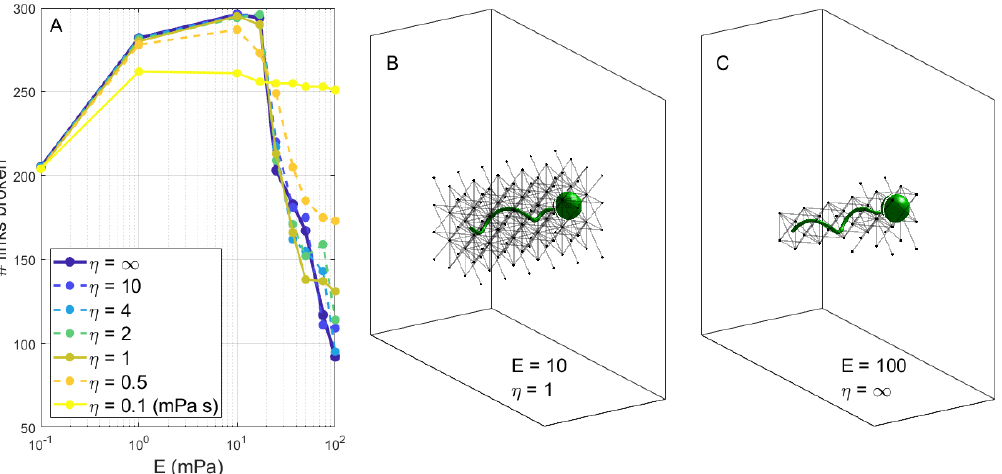
Figure 8. Summary of results for a swimmer with the ability to dissolve nearby links moving through networks with different viscoelastic properties. The range of the stiffness constant is 0.1 ≤ E ≤ 100 mPa and of the dashpot parameter is 0.1 ≤ η ≤ 10 and η = ∞ . Panel ( A ) shows the number of links broken from t = 0 s until the swimmer crossed the network and reached the network-free swimming speed. Panels ( B , C ) show, at t = 0, the links that were ultimately broken later during the simulation for two choices of E and η ; images of the swimmer are shown for perspective.